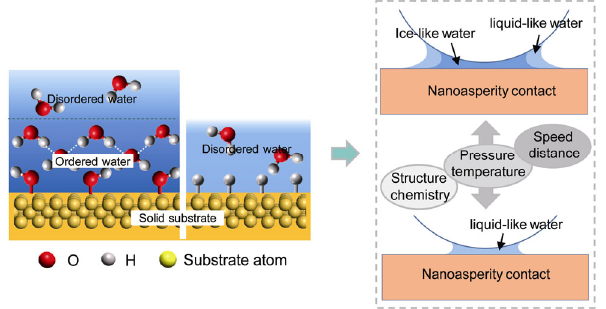
Fig. 1 Water adsorption on solid surface and water condensation at contact or near-contact interface: (a) water adsorption on solid surface with different configurations depending on surficial termination groups and water vapor pressures. (b) Schematic of water condensation at contact or near-contact asperity–contact interface depending on solid surface chemistry and structure, environments (i.e., vapor pressure and temperature), and experimental conditions (i.e., sliding speed and contact